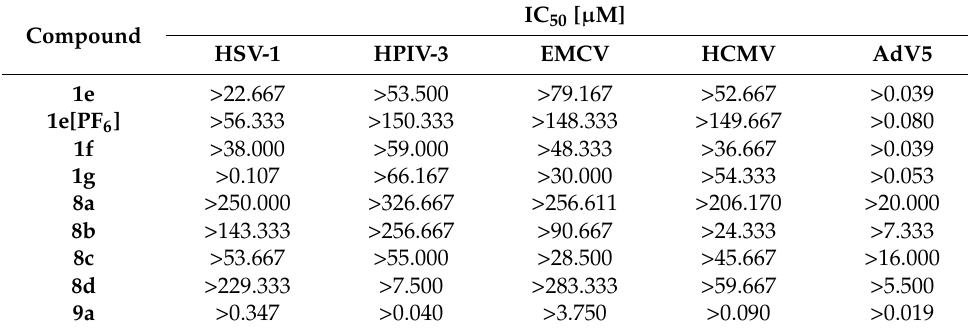
Table 2. Antiviral activity of compounds 1e – 1g , 1e[PF 6 ] , 8a – 8d , and 9a